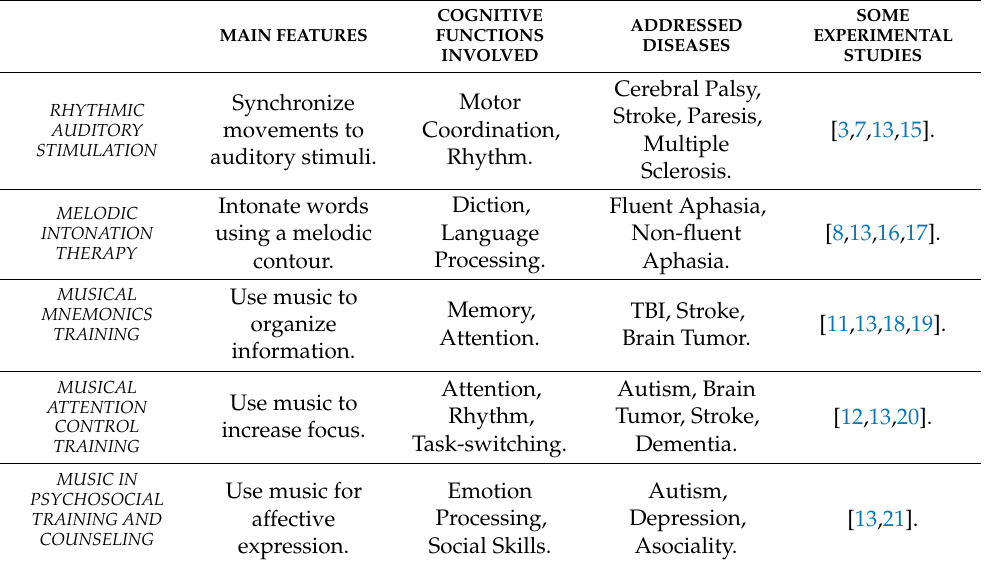
Table 1. Summary of the reviewed music rehabilitation